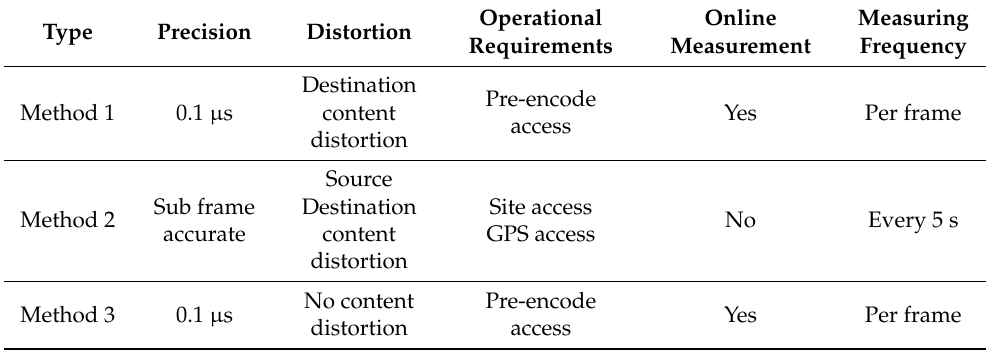
Table 2. Pro and cons of 3 proposed methods.